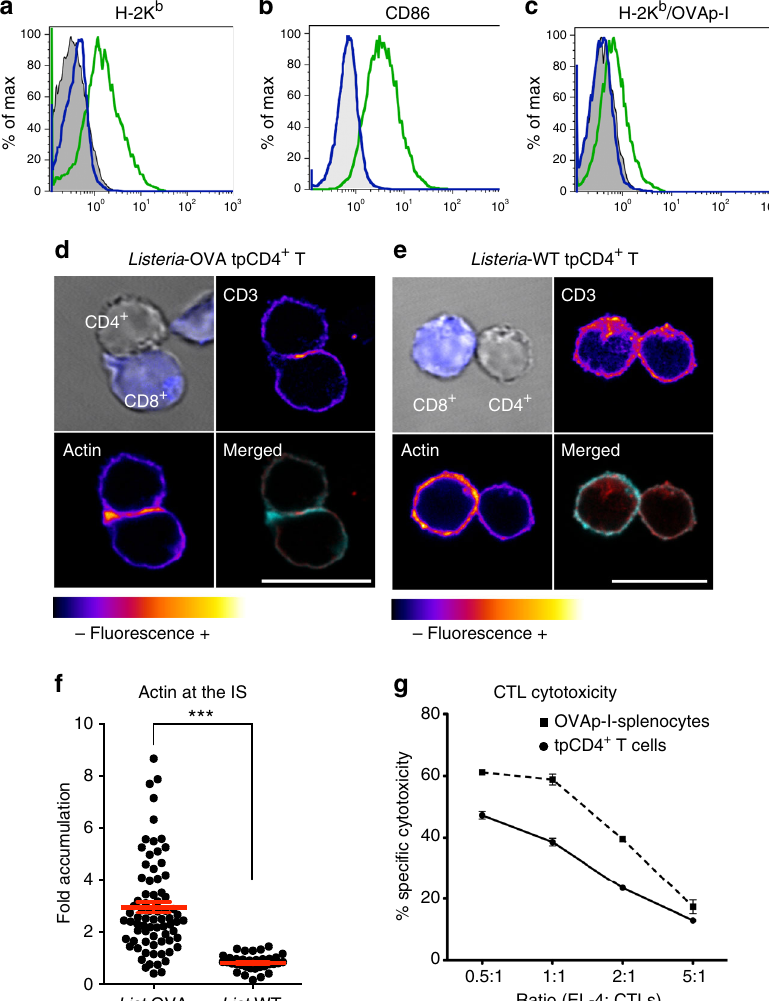
Fig. 3 tpCD4 + T cells establish immune synapses with naive CD8 + T cells. H-2K b ( a ) or CD86 ( b ) expression on CD4 + T cells before (blue line) and after Listeria-OVA transphagocytosis (green line). Antibody negative controls are shown (grey). c H-2K b /OVA expression on Listeria-OVA tpCD4 + T cells, 24 (blue) or 48 h (green) post-transphagocytosis and on non-transphagocytic T cells (grey). Confocal images of Listeria - OVA ( d ) or Listeria - WT tpCD4 + T cells ( e ) incubated 1 h with OT-I naive CD8 + T cells (blue). CD3 and actin fl uorescence is shown on a “ fi re ” scale. Merged images show actin (cyan) and CD3 (red). Bars = 10 μ m. f Quanti fi cation of actin accumulation at the IS analyzed using Synapse measures software 31 . Naive OT-I CD8 + T cells were conjugated with Listeria-OVA or Listeria WT tpCD4 + T cells and fl uorescence microscopy was performed as in d and e . Each dot represents the fold increase of actin accumulation in the IS in an individual CD8 + /tpCD4 + T cell contact from three independent experiments, the mean and the s.e.m. are shown in red. *** P < 0.001 (analyzed by Mann – Whitney U -test). g Relative speci fi c cytotoxicity of effector CD8 + T cells (CTL) activated by Listeria-OVA tpCD4 + T cells (solid line) or by OVAp-I-loaded splenocytes (dashed line). Various EL-4 (target cell):CTL ratios were